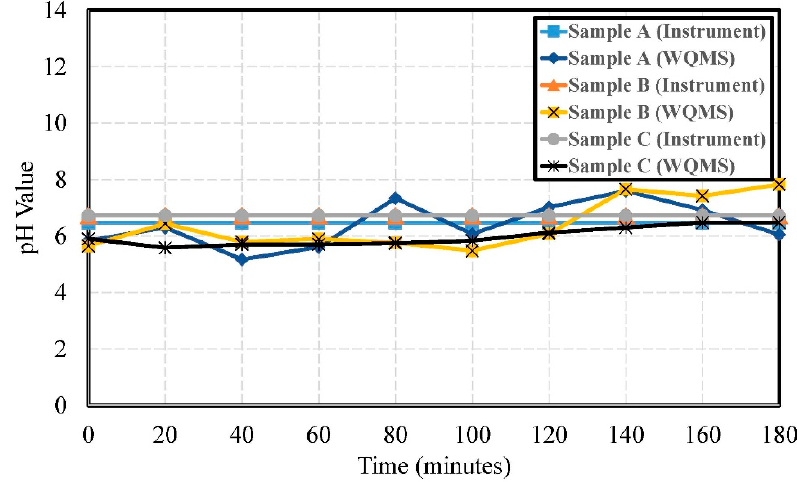
Figure 9. The experimental results of the pH values by using Samples A, B, and C.